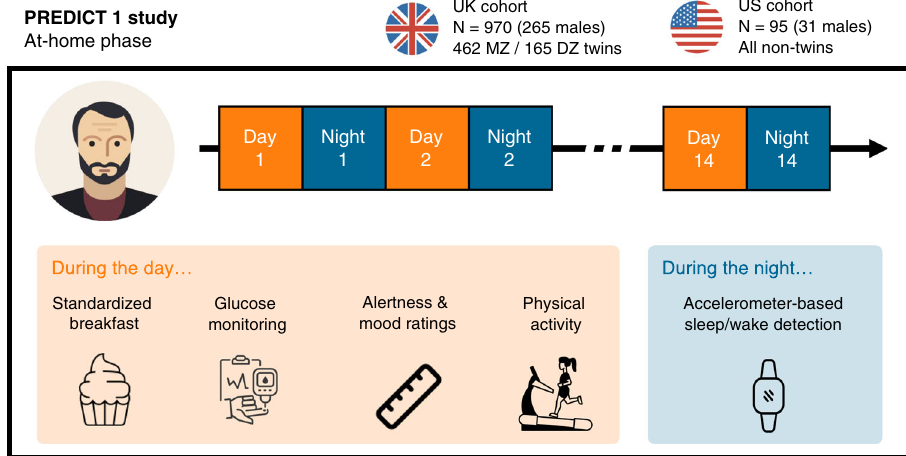
Fig. 1 | Experimental design. The Personalized Responses to Dietary Composi- tion Trial (or “ PREDICT1 ” ) is a two-country (UK, US) longitudinal study whose pri- mary goal is to predict metabolic responses to foods based on the individual ’ s characteristics, including molecular biomarkers and lifestyle factors, as well as the nutritional composition of the food 8 . PREDICT1 consists of one clinic baseline visit followedbyatwo-weekhome-basedstudy.Duringtheat-homephase,participants consumed multiple standardised test meals differing in macronutrient composi- tion, while wearing an accelerometer wristwatch and a continuous glucose moni- tor. The former was used to determine sleep/wake activity during the night and ef fi ciency, and sleep timing — predicts subsequent changes in next-